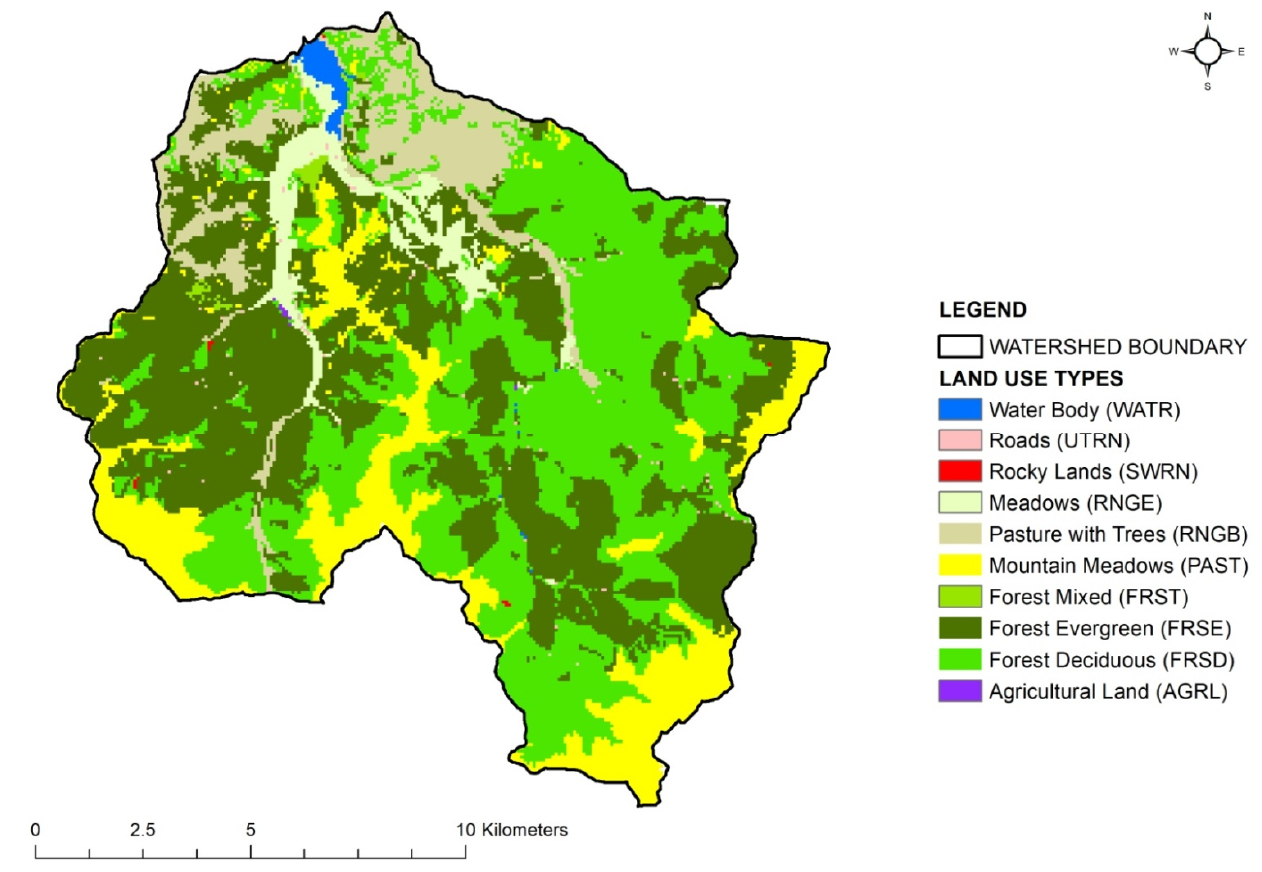
Figure 4. Land use at the Tărlung watershed level.